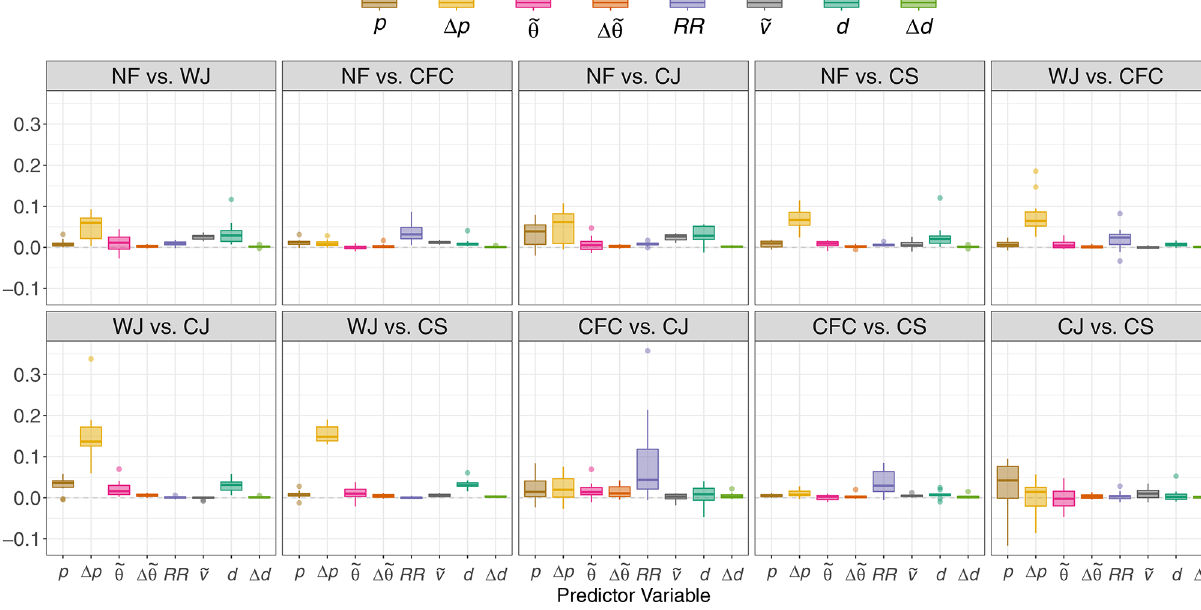
Figure 9. Boxplots of the BS permutation importance of the RF probabilities comparing two wind features for the predictor variables in the all-pairs approach. The boxplots are calculated over the individual winter